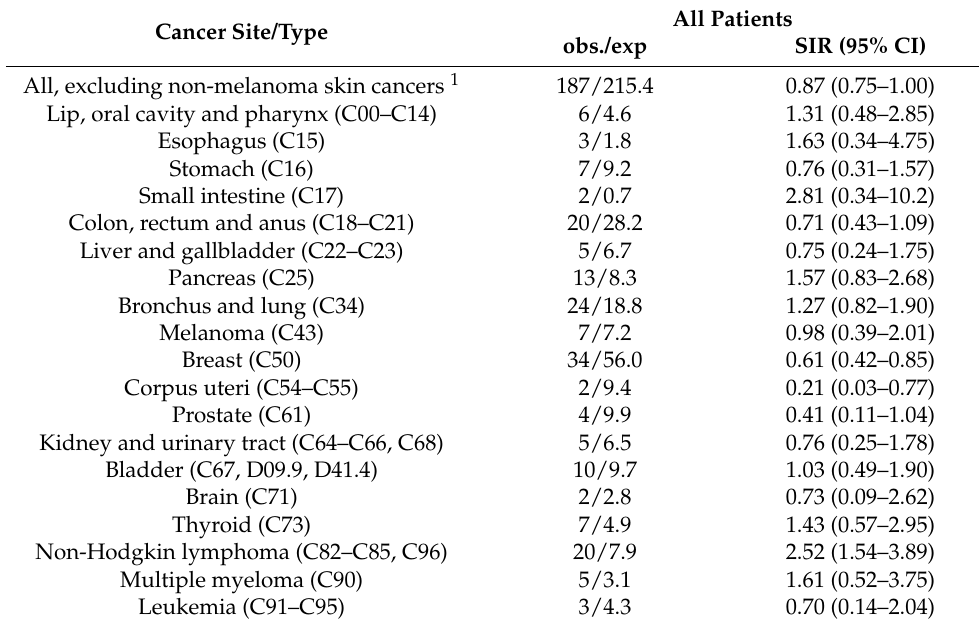
Table 2. Standardized incidence ratios (SIRs) and 95% confidence intervals (CIs) for de novo malig- nancies by cancer site/type. Friuli Venezia Giulia,